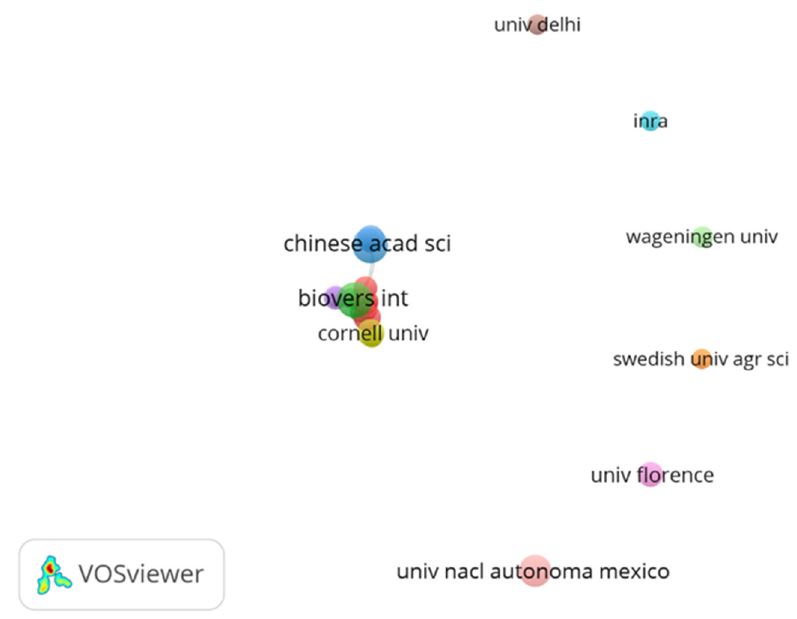
Figure 5. The collaboration network of institutions about the agrobiodiversity and traditional knowledge.